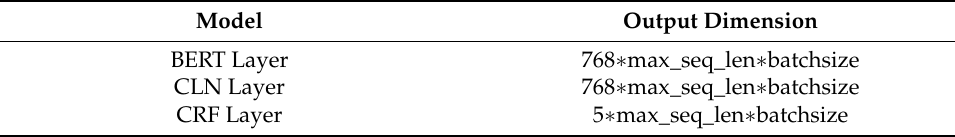
Table 5. BERT-CLN network